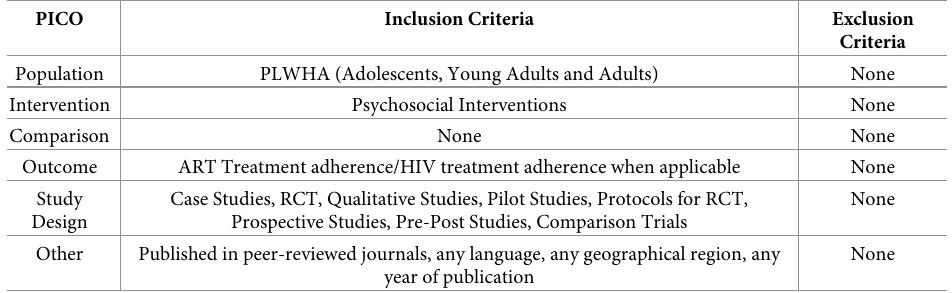
Table 1. PICO, inclusion criteria, and exclusion criteria applied to literature search.